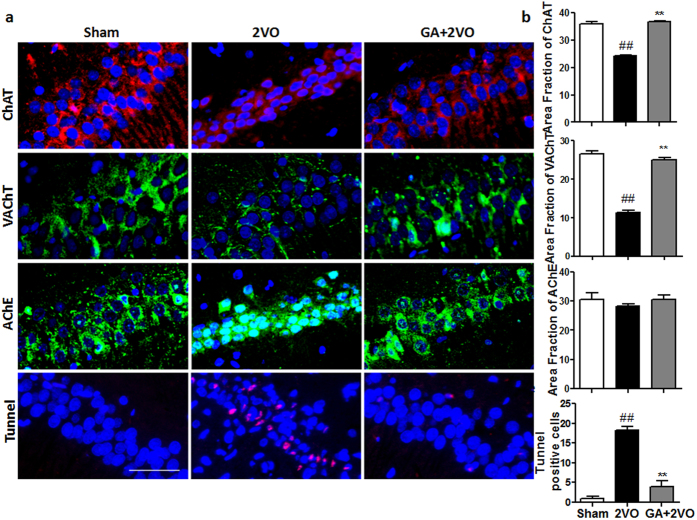
GA treatment increased the production of cholinergic activity in the CA1 area of the hippocampus in 2VO rats (magnification: 200×).(a) Representative images of cholinergic activity and neurocyte apoptosis in the hippocampal CA1 area as seen by fluorescence microscopy: immunostaining for ChAT (red), immunostaining for VAChT (green), immunostaining for AChE (green) and immunostaining for Tunnel (red). (b) Quantification of GA’s effect on ChAT, VAChT, AChE and Tunnel-positive cells. As visible in the GA group, the decrease of ChAT and VAChT activity induced by cerebral hypoperfusion are significantly alleviated compared to that in the 2VO group (P < 0.01); however, the effect on AChE activity was not significant (P > 0.05). At the same time, administration of GA prevented the apoptosis of neurons. Scale bar = 50 μm. n = 4. Data were analyzed by ANOVA, shown are means ± SEM (*P < 0.05 and **P < 0.01 as compared to the 2VO group, #P < 0.05 and ##P < 0.01 as compared to the sham group).